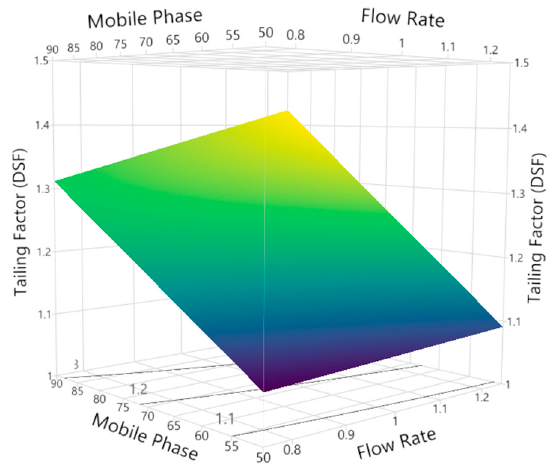
Figure 6. Three-dimensional response surface plot for the effect of flow rate (X 1 ) and mobile phase composition (X 2 ) on DSF tailing factor.